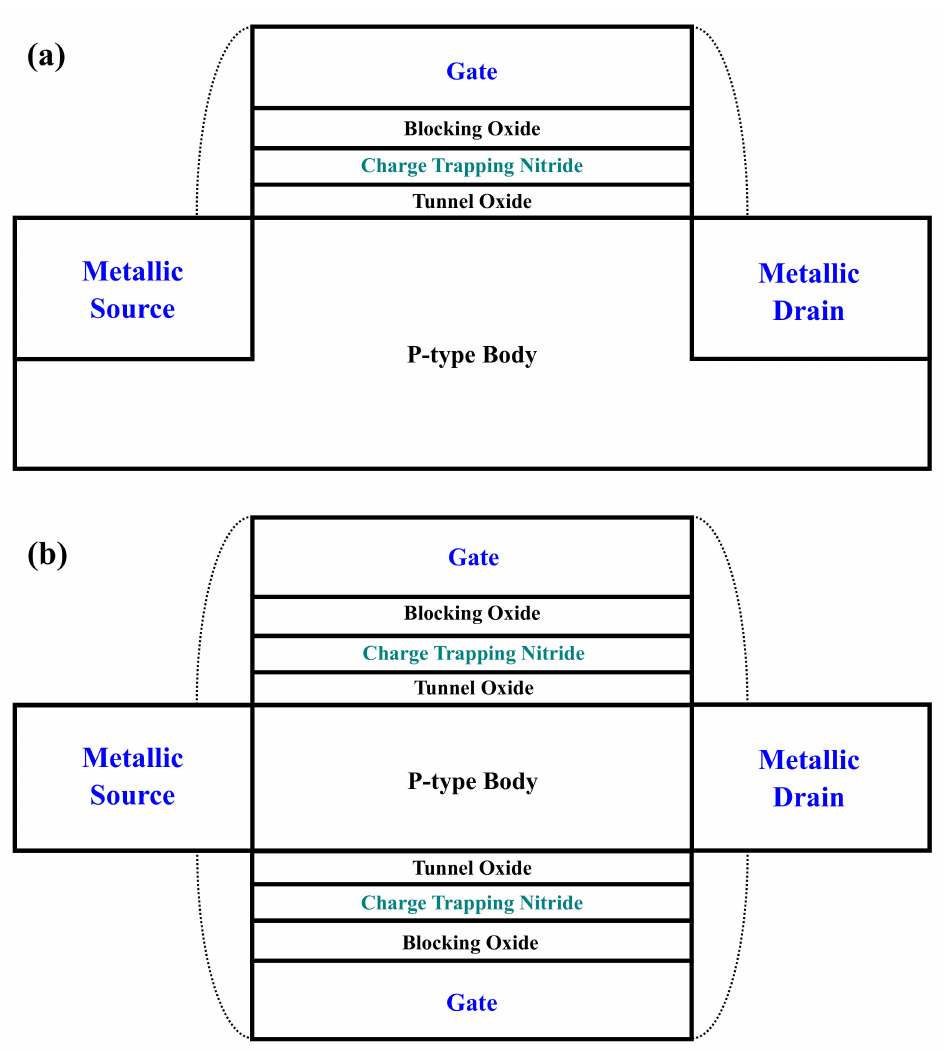
Figure 1. Schematic structures of ( a ) traditional single-gate and ( b ) non-planar double-gate Schottky barrier charge-trapping memory